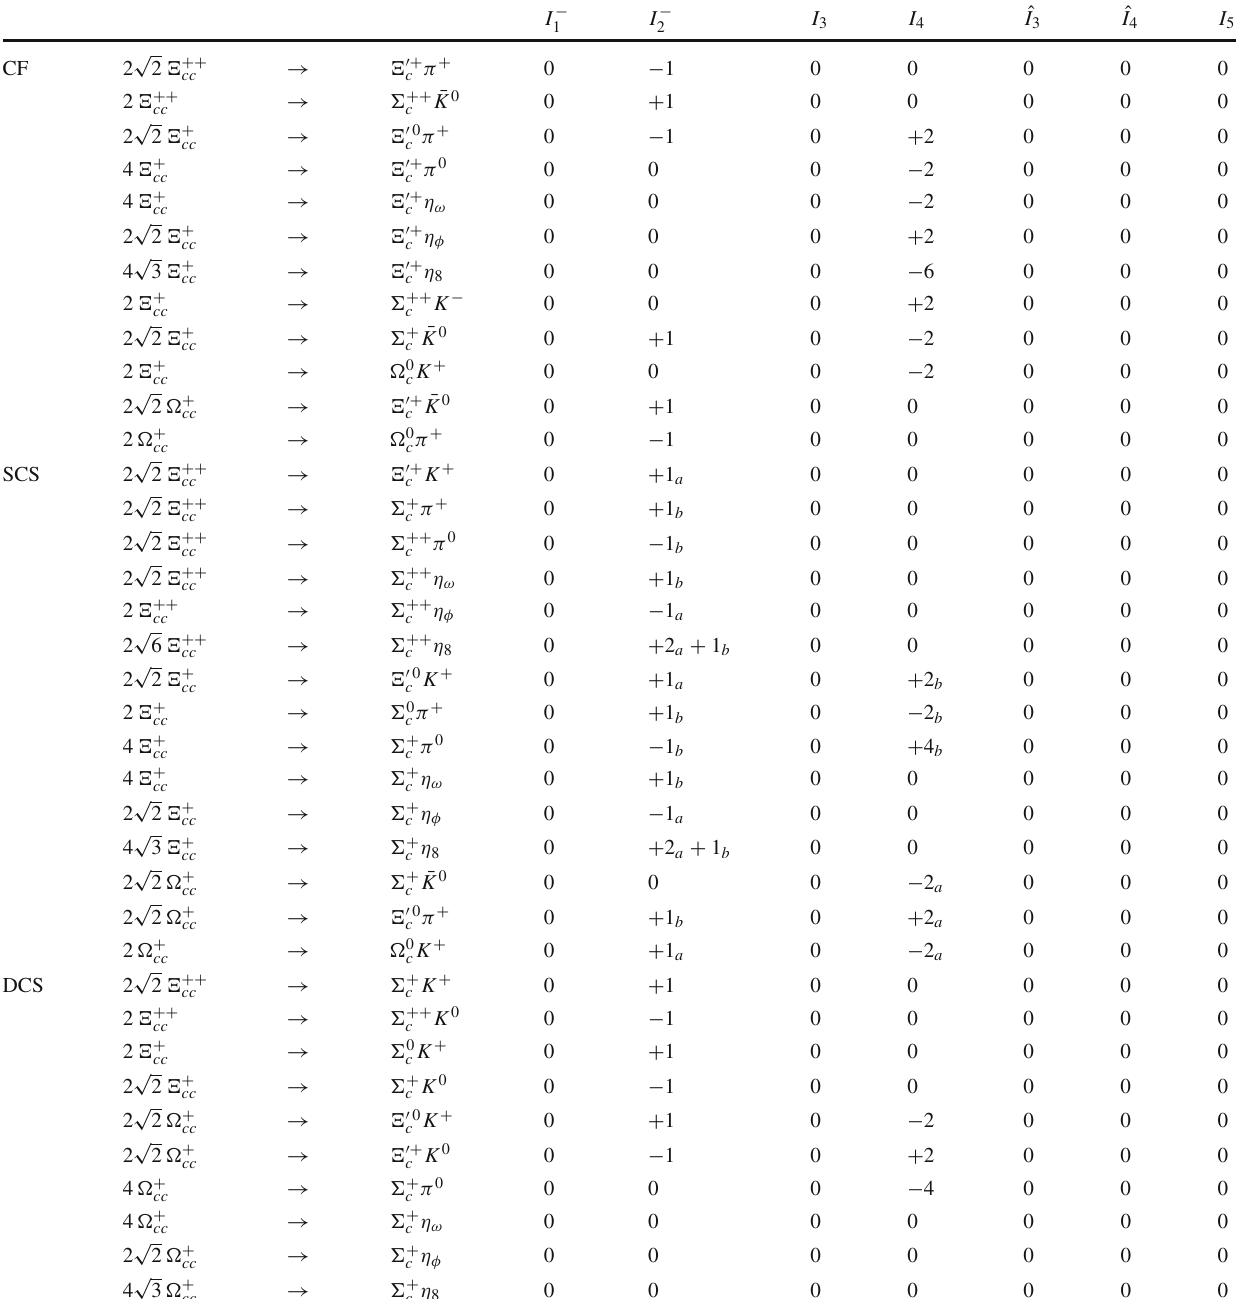
Table 11 Values of the seven tensor invariants for the CF, SCS and DCS decays of the triplet double charm baryon states (cid:6) ++ cc , (cid:6) + cc , and (cid:10) + cc into sextet single baryon states, B cc